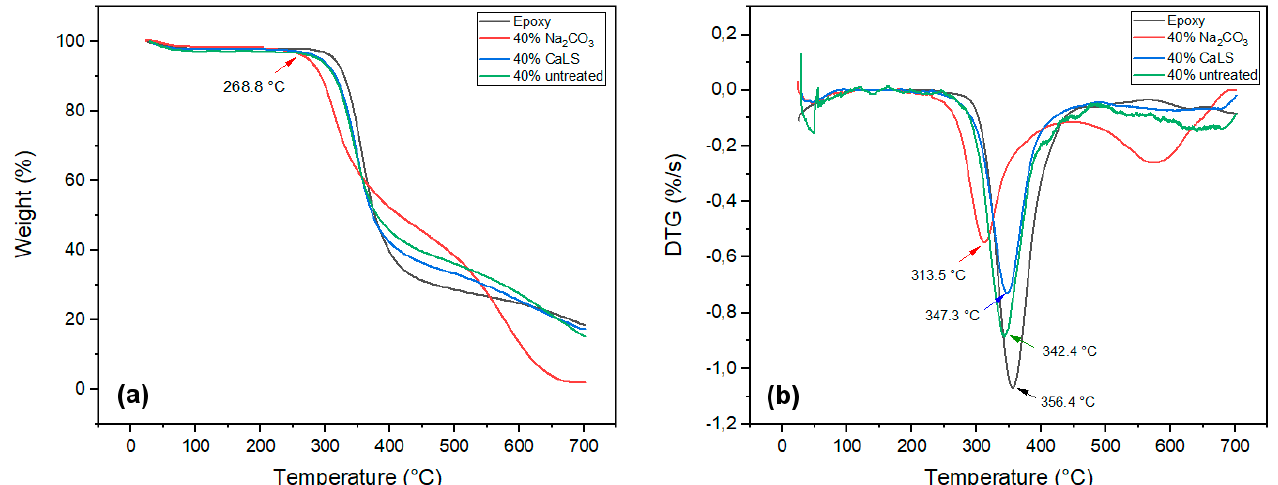
Figure 6. ( a ) TG curves for composites with 40 vol% of treated fibers ( b ) DTG curves for composites with 40 vol% of treated fibers.